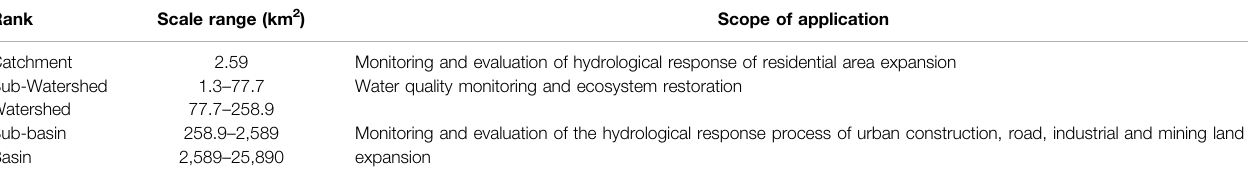
TABLE 2 | Watershed scale and scope of application (source: United States Environmental Protection Agency). Rank Scale range (km 2